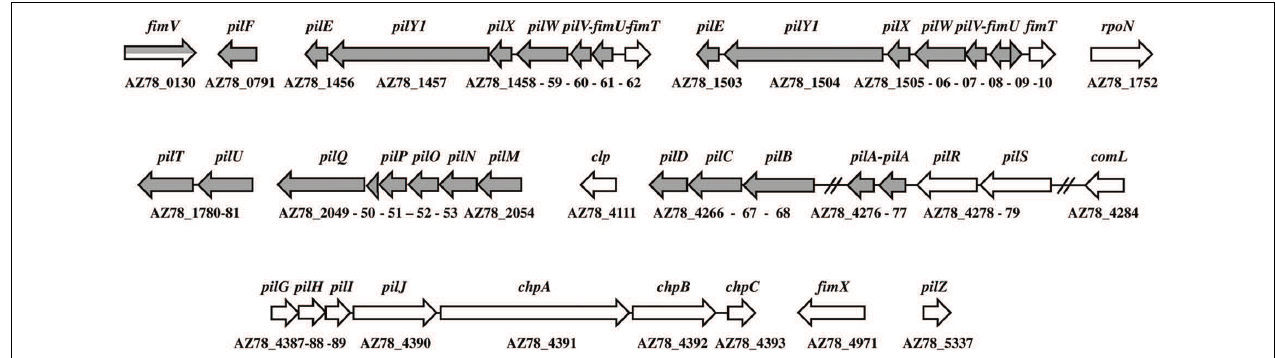
FIGURE 3 | Type IV pili gene organization in the Lysobacter capsici AZ78 genome. Putative genes encoding structural components of the type IV pilus are in gray, and putative genes encoding regulatory components are in white. The gene names are given above the arrows. The corresponding accession number is given under each